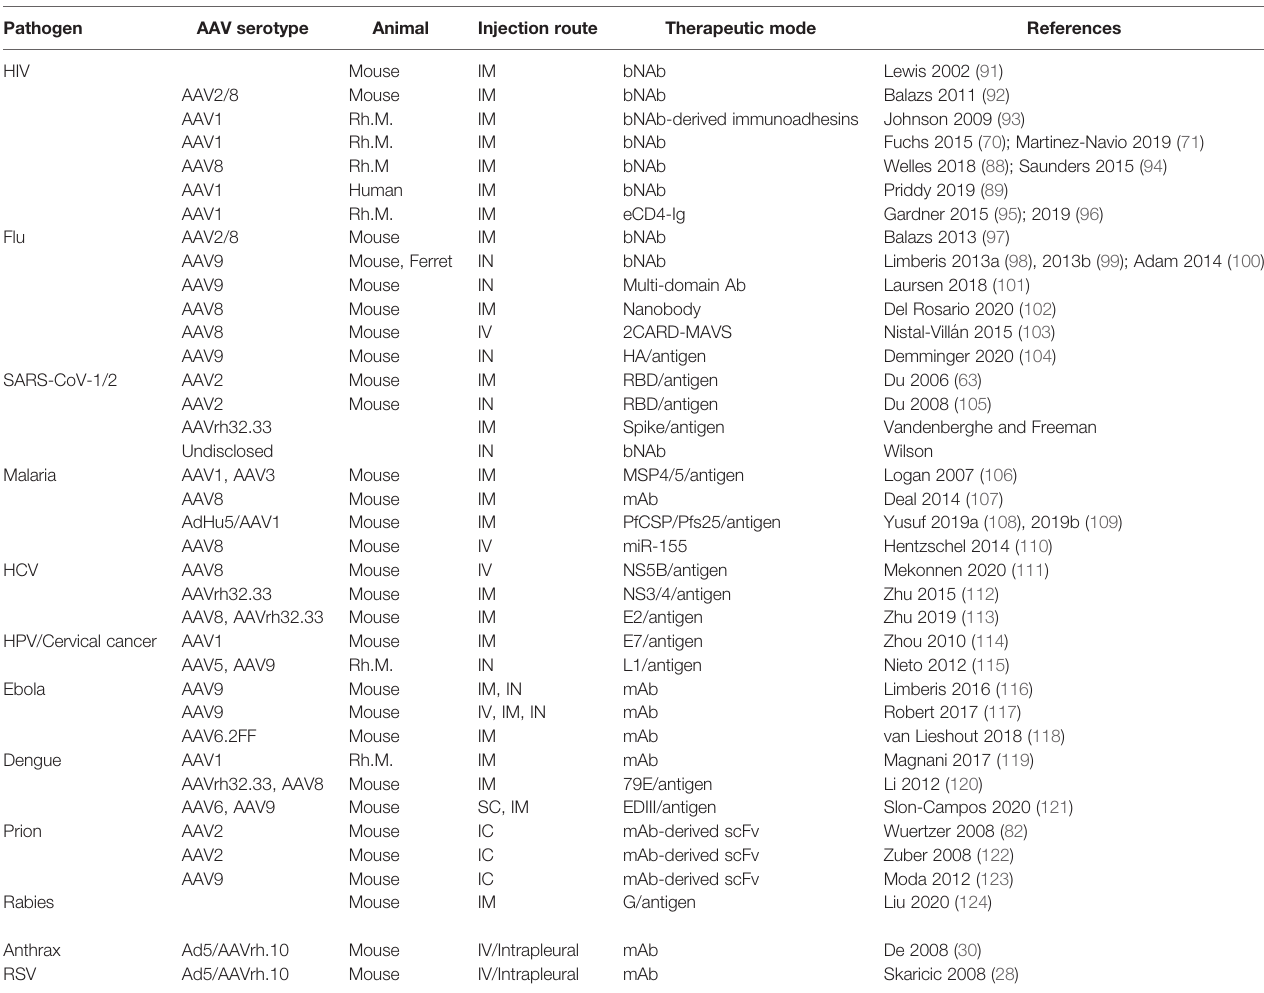
TABLE 1 | List of AAV-vectored immunotherapeutic strategies. Pathogen AAV serotype Animal Injection route Therapeutic